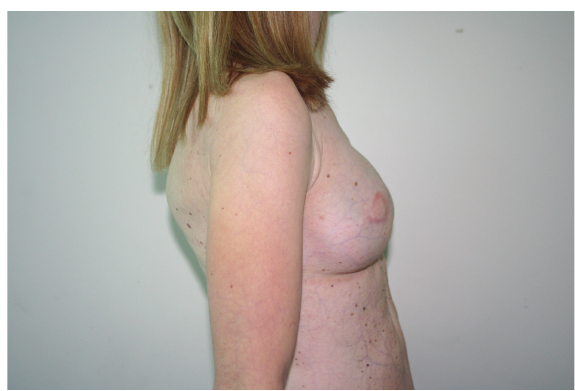
Figure 8: Postoperative lateral view, showing a good projection of the reconstructed